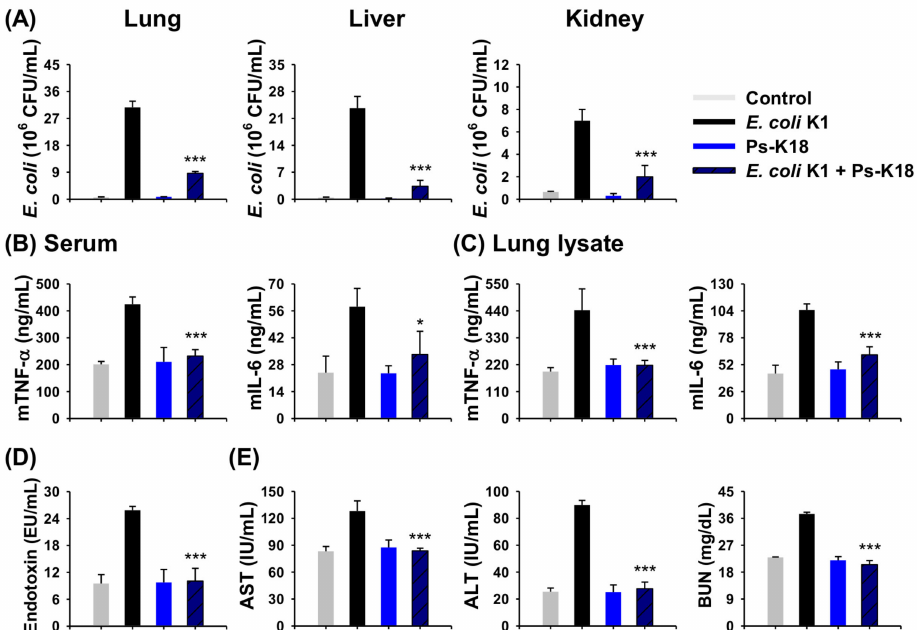
Figure 6. E ff ects of Ps-K18 on septic shock in mice induced by E. coli K1. ( A ) Inhibition of bacterial growth in the lung, liver, and kidney of the septic shock model. BALB / c mice were pre-treated with 1 mg / kg of peptide, followed by intraperitoneal injection with E. coli K1 (1 × 10 6 CFU / mouse). ( B ) Inhibition of cytokine production (mTNF- α and mIL-6) in the serum. ( C ) Inhibition of cytokine production (mTNF- α and mIL-6) in lung lysates. ( D ) Reduction of LPS endotoxin by Ps-K18 in serum of the E. coli K1-induced sepsis model. ( E ) AST, ALT, and BUN levels in the mouse septic shock model induced by E. coli K1. Data are presented as means ± standard errors of the mean (* p < 0.05; ** p < 0.01; *** p < 0.001; ns. represents no significance) compared to E. coli K1-injected group. All measurements were obtained five